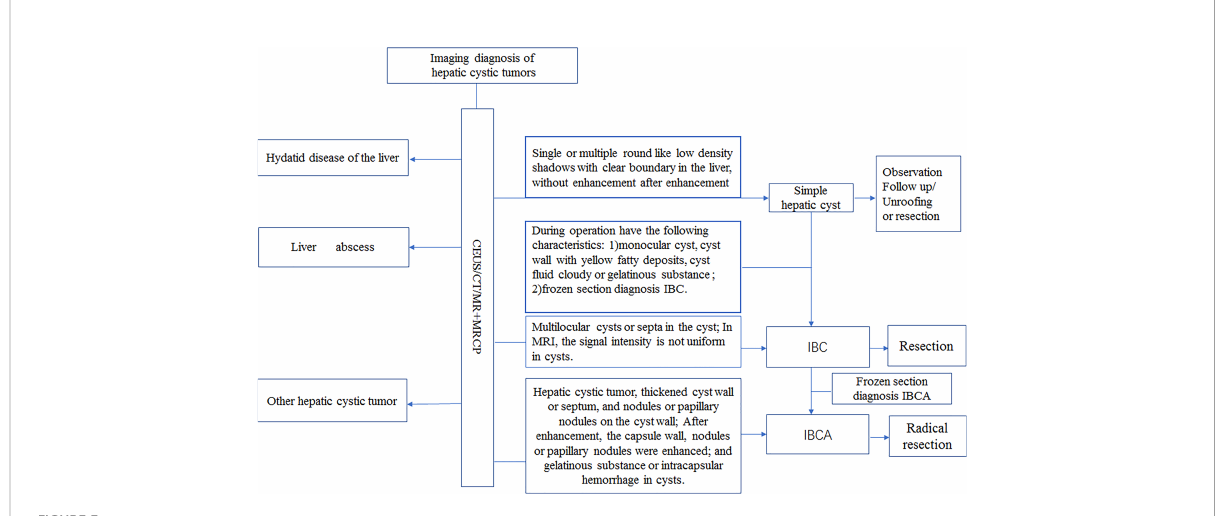
FIGURE 3 Classi fi cation and management of hepatic cystic